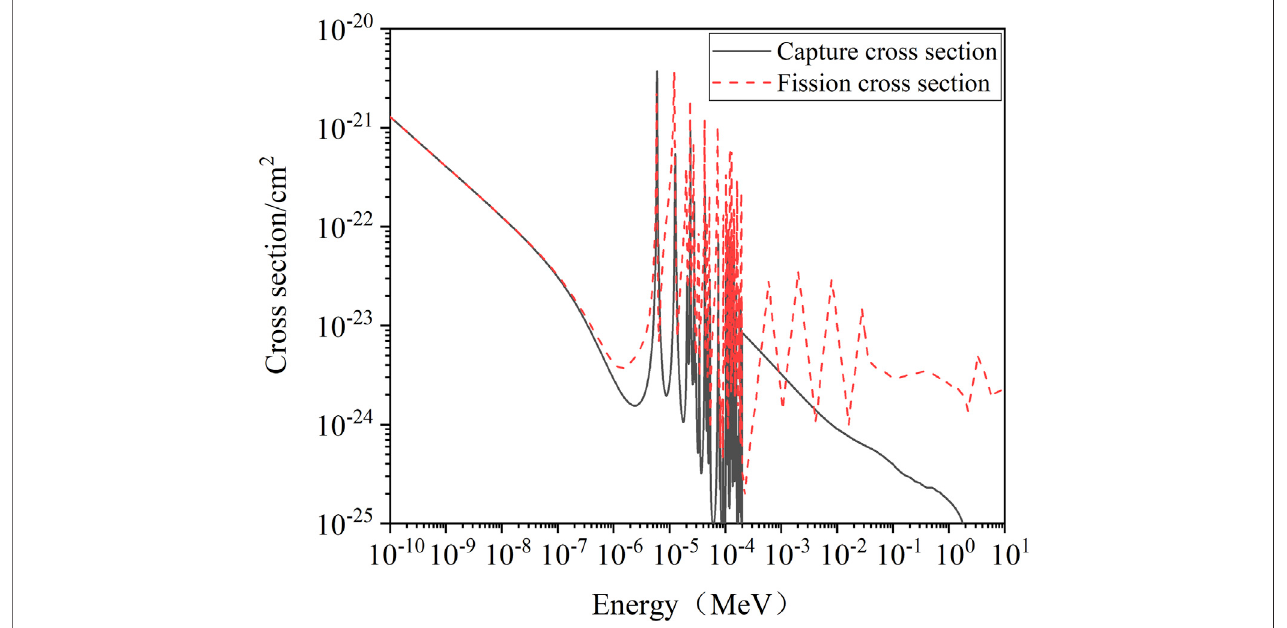
FIGURE 5 | Capture and fi ssion cross sections of 232